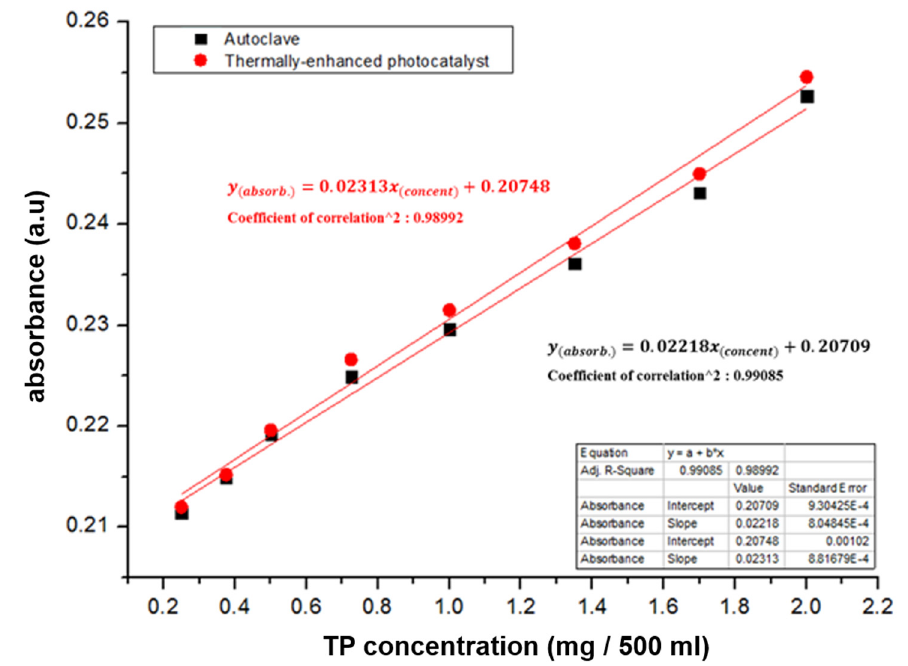
Figure 13. Comparison of the relationship between phosphorus concentrations and measured absorbance at a wavelength of 975 nm.